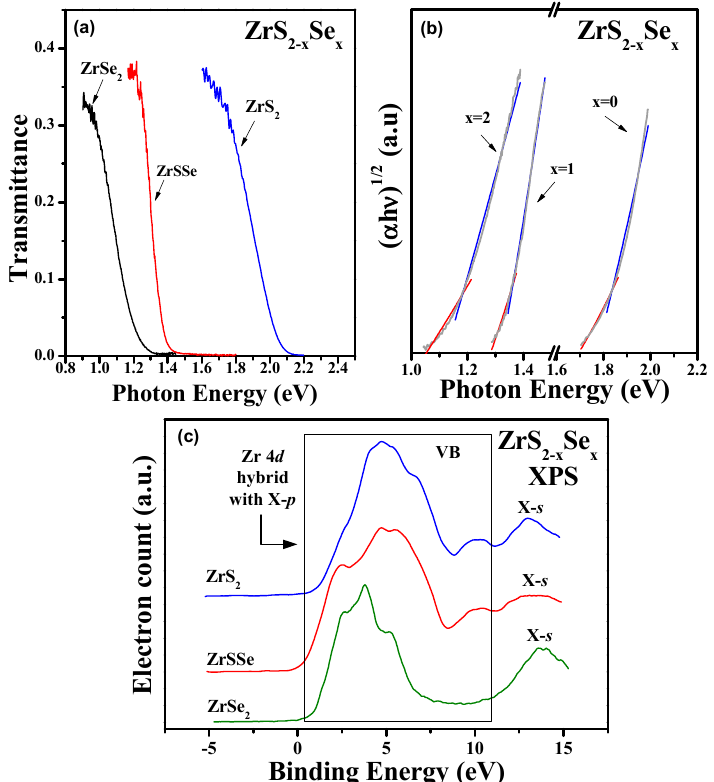
Figure 3. ( a ) Transmittance spectra of ZrS 2 − x Se x (x = 0, 1, and 2) at 300 K. ( b ) Plot of ( α h ν ) 1/2 versus h ν for the analysis of indirect gaps of ZrS 2 − x Se x (x = 0, 1, and 2) at 300 K. ( c ) Valence-band XPS spectra of ZrS 2 − x Se x (x = 0, 1, and 2) compounds.